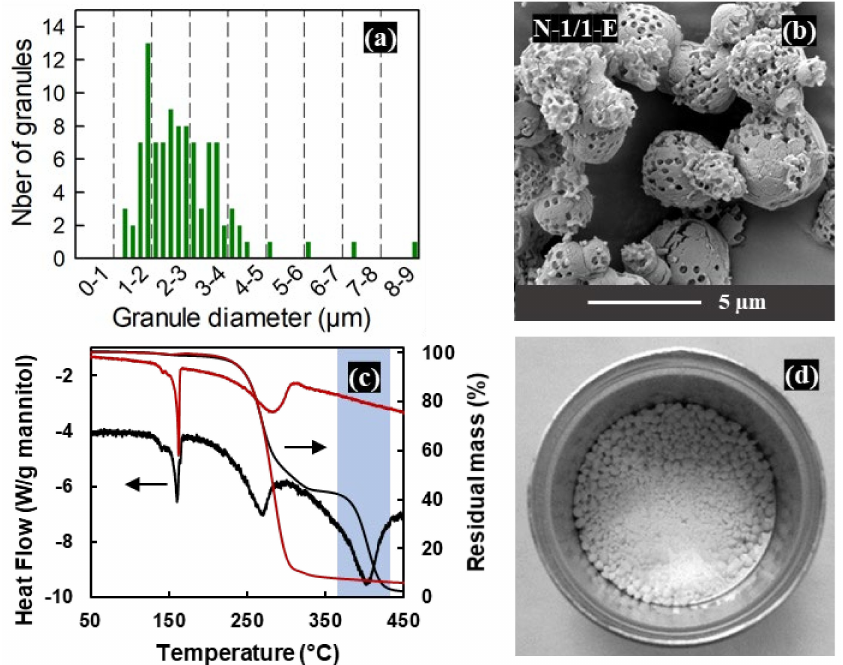
Figure 7. Upscaling of the synthesis for the M:PS ratio = 1:1 composition in the Niro pilot‑scale spray dryer with the two‑fluid nozzle: ( a ) histogram of the granule diameters, ( b ) SEM micrograph of the granules after etching, ( c ) TGA/DSC curves before (in black) and after (in red) etching, ( d ) photograph of the agglomerated formulation after mixing with the budesonide